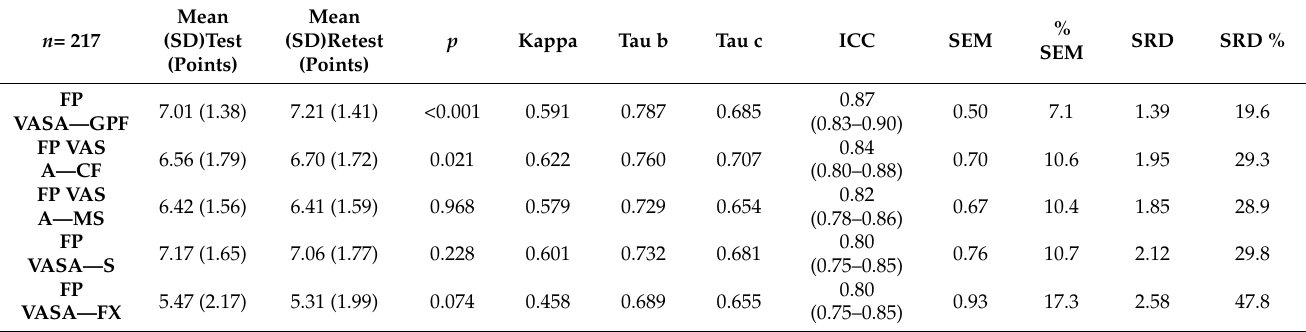
Table 4. Test–retest reliability of the FP VAS A in two measurements with an interval of 15 days between